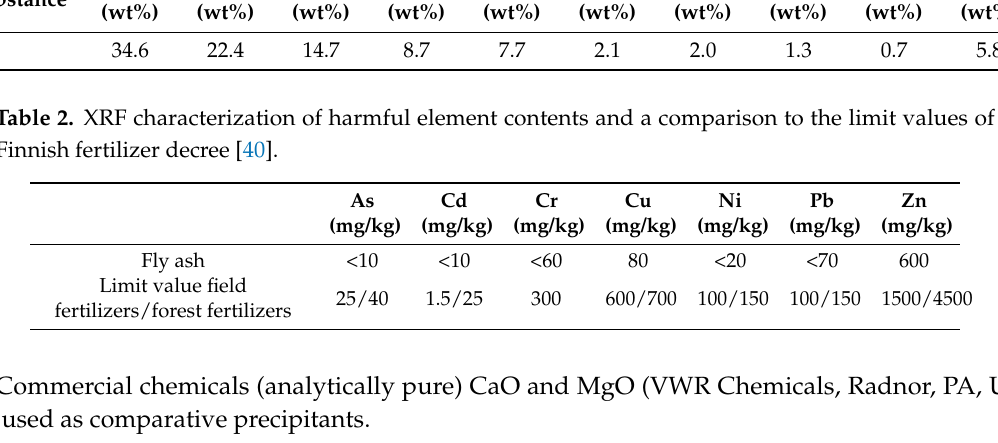
Table 1. X-ray fluorescence spectrometer (XRF) characterization of the main components of fly ash. Substance